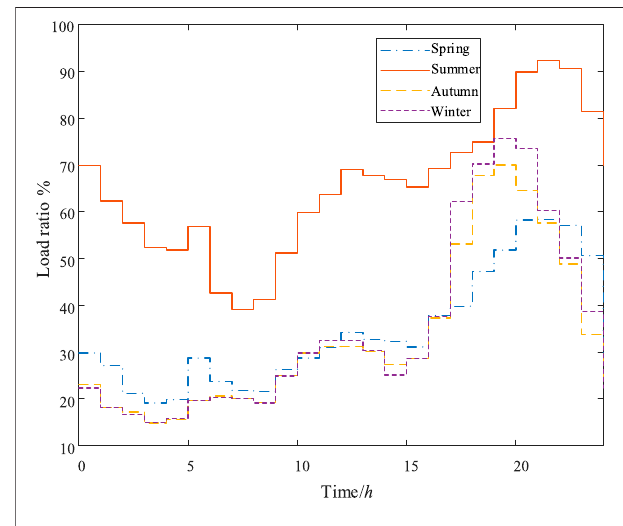
FIGURE 3 | Annual load curve of